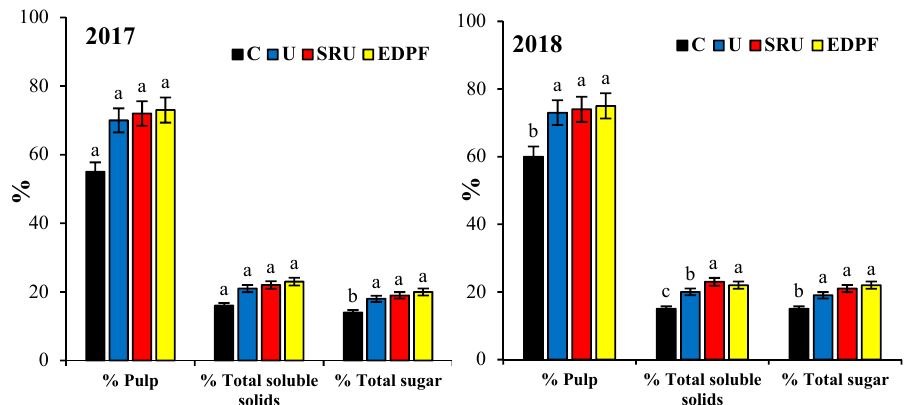
Figure 2. Effect of nitrogen forms on the fruit quality of banana fingers. C = control, U = urea, SRU = slow-release urea, and EDPF = expired dairy products fertilizer. Means (± standard deviation, n = 5) in the same column with different letters show significance based on Duncan’s test at p < 0.01.